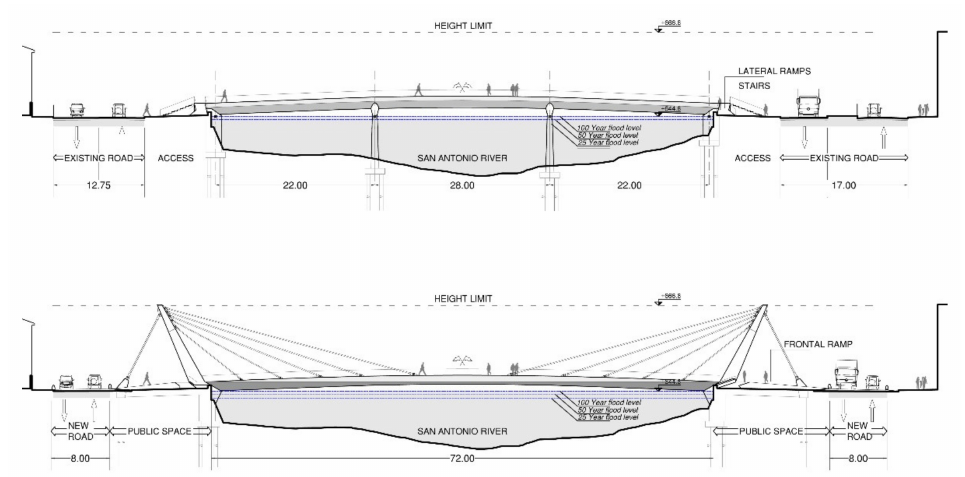
Figure 8. Top : early 3-span proposal: accesses were uninviting as ramps could only occur laterally. Bottom : selected single-span cable-stayed typology, together with new public spaces and road reconfigurations for friendlier accesses.